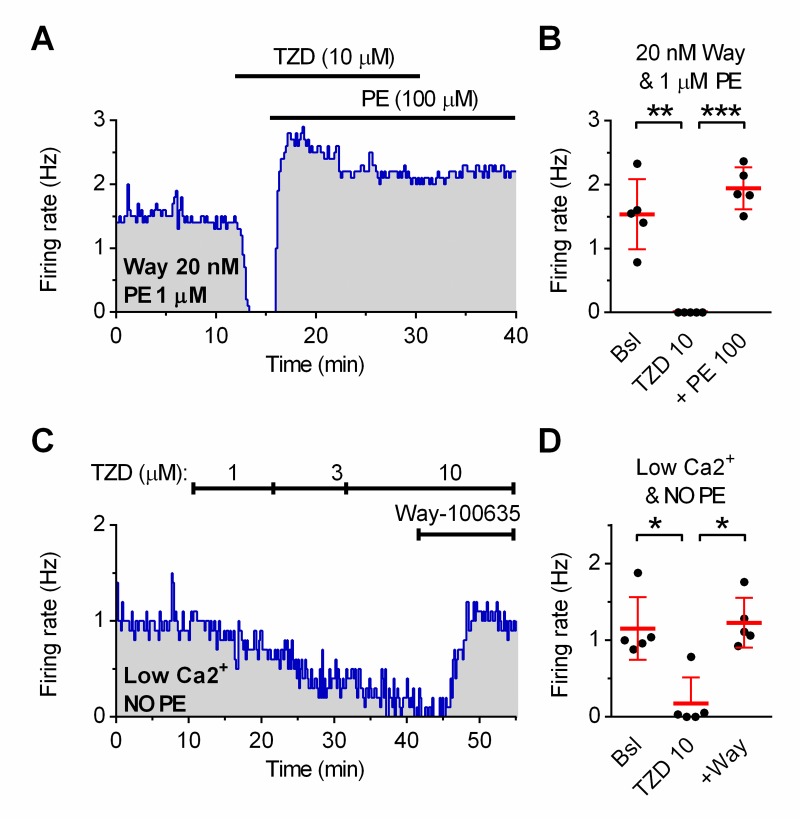
Antagonism at α1-adrenoceptors by trazodone contributes in the inhibition of serotonergic neuron activity.(A) Representative recording of neuron activity facilitated by 1 μM phenylephrine (PE) in the presence of Way-100635 (+Way; 20 nM). The inhibitory effect of 10 μM trazodone (TZD) is surmounted by addition of 100 μM phenylephrine (PE). (B) Summary of five experiments (mean ± SD; One-way RM ANOVA: F(2,4) = 48.74; p <0.0002). (C) Representative recording of the concentration-dependent effect of trazodone on neuron activity facilitated by low calcium ACSF (see
methods) in the absence of PE. (D) Summary of five experiments (mean ± SD; One-way RM ANOVA: F(2,4) = 16.21; p <0.0122) * p< 0.05; ** p< 0.01; *** p< 0.001 (One-Way RM ANOVA followed by Tukey post-hoc test).